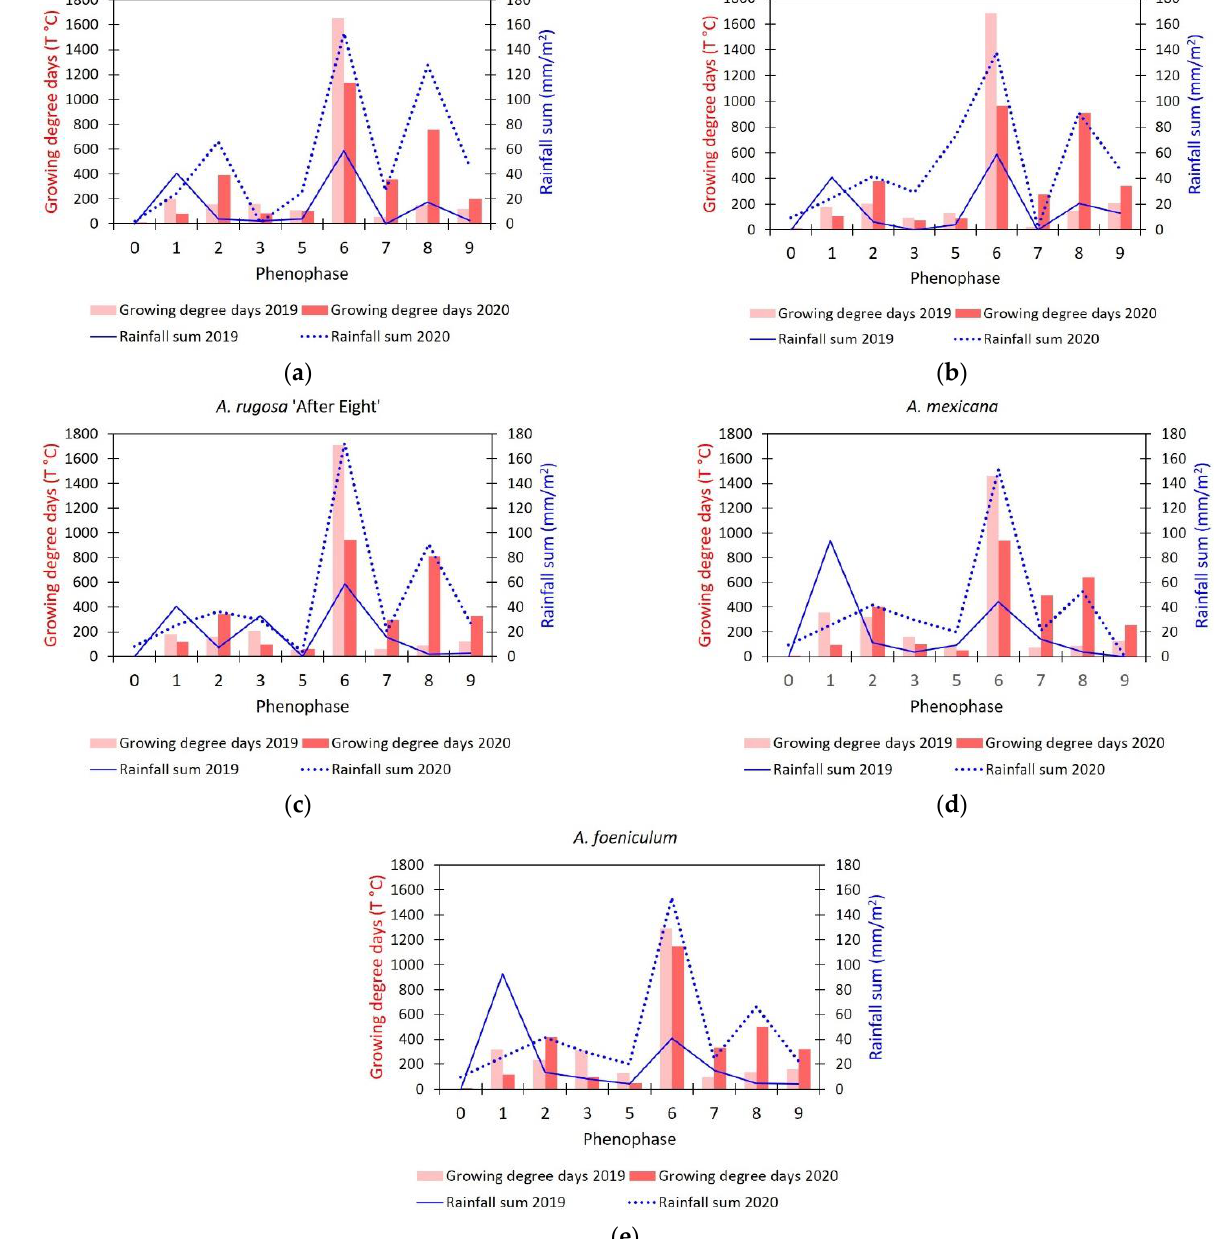
Figure 7. Growing degree days and rainfall sum per phenophase (BBCH 0 – 9) in Agastache ( a – e ) in Cluj-Napoca.